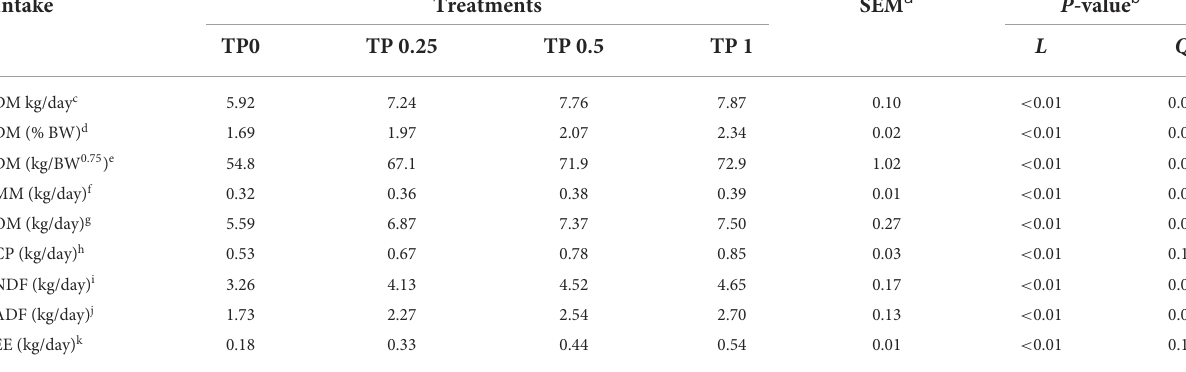
TABLE 2 Intake of dry matter and nutrients in female buffaloes supplemented with palm kernel